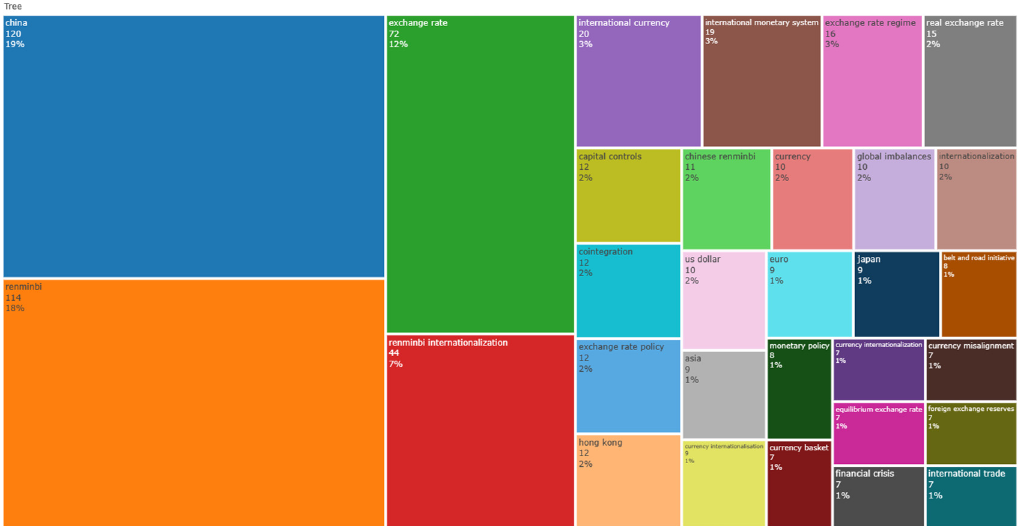
Figure 5. Top authors’ keywords as a Tree Map. Source: Authors’ elaboration using Biblioshiny.